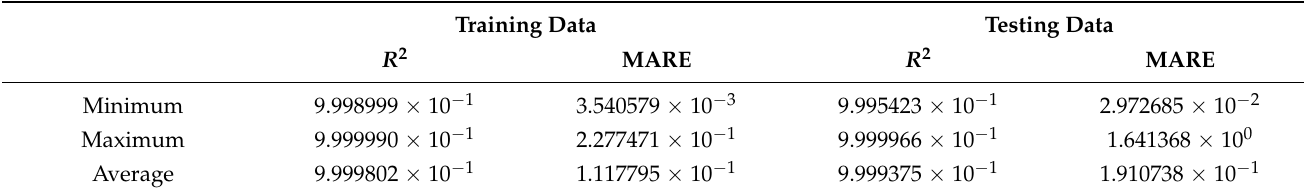
Figure 11. Actual versus predicted basis coefficients with the testing data. ( a ) 1st coefficient a 1 . ( b ) 2nd coefficient a 2 . Table 4. Numerical verification results of the constructed reduced EMF simulation with the training and testing